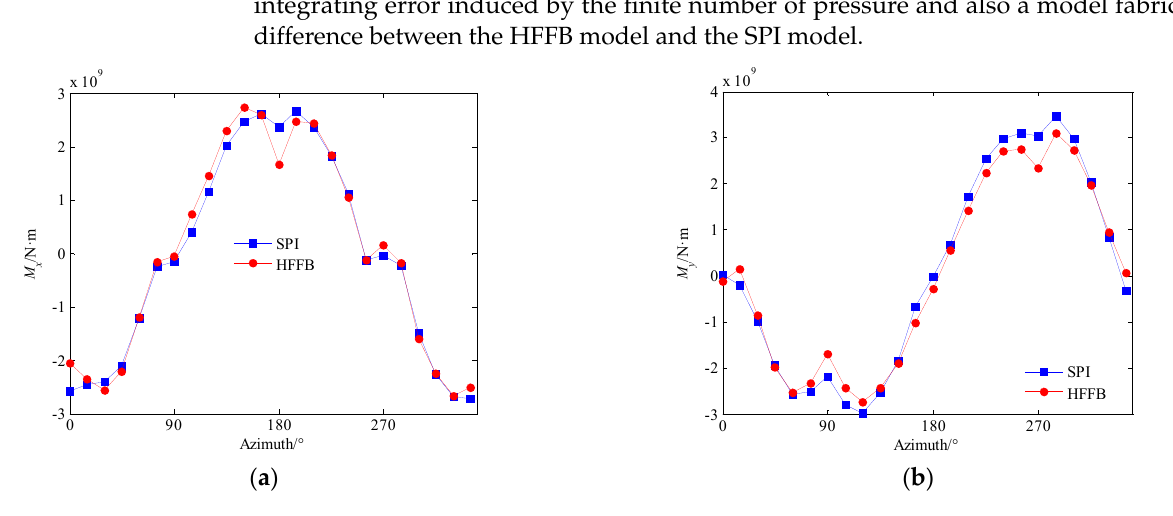
Figure 10. Comparison of the mean base overturning moment using SPI and HFFB tests: ( a ) M x . ( b ) M y .